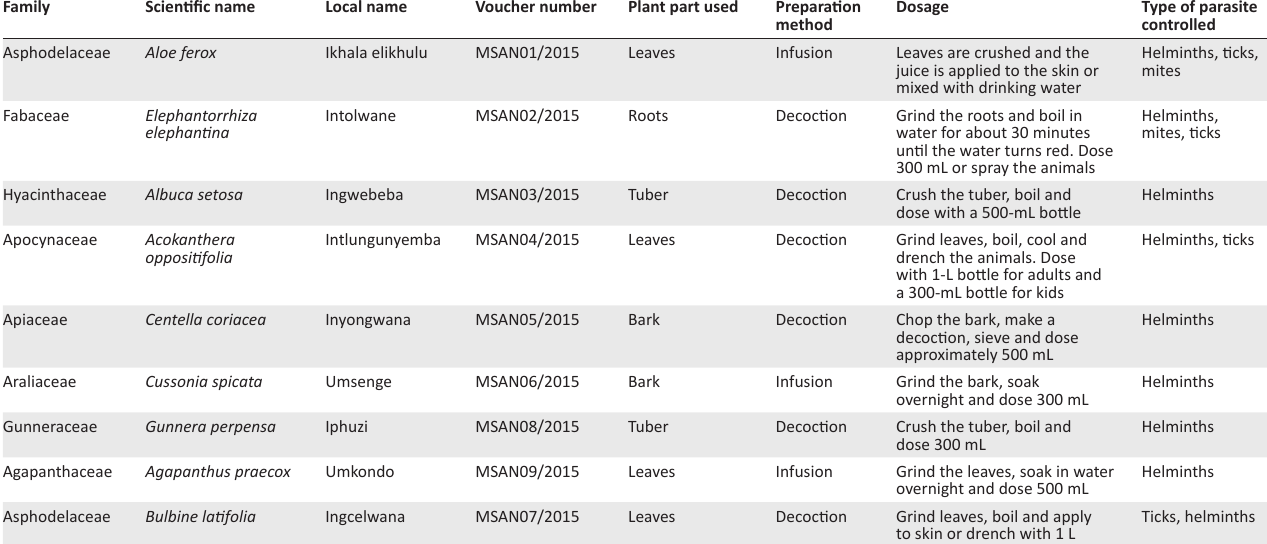
TABLE 3: Plants used to control parasites in